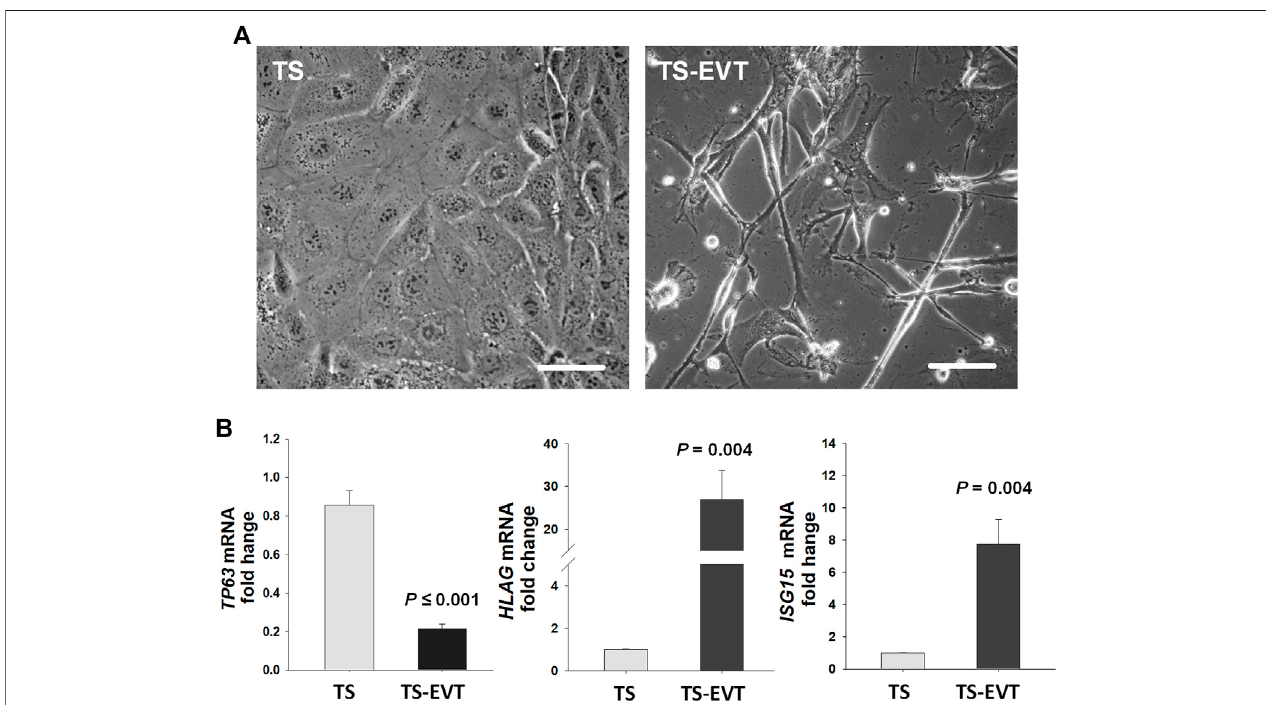
FIGURE 3 | In vitro differentiation of trophoblastic stem cells into extravillous trophoblasts signi fi cantly enhance ISG15 mRNA levels. (A) Cultured trophoblastic stem (TS) cells display polygonal shapes with tight cell-cell attachments whereas TS induced extravillous trophoblastic (TS-EVT) cells display elongated cell morphology withmultipleprotrusionandlesscell-cellcontacts. (B) TP63 , HLAG ,and ISG15 mRNAlevelsinTSvs.TS-EVTcells.BarsrepresentMean±SEMandcomparedbyusing t -test. TS cells ( n = 6), TS-EVT cells ( n = 5). Scale bars = 30 µm.